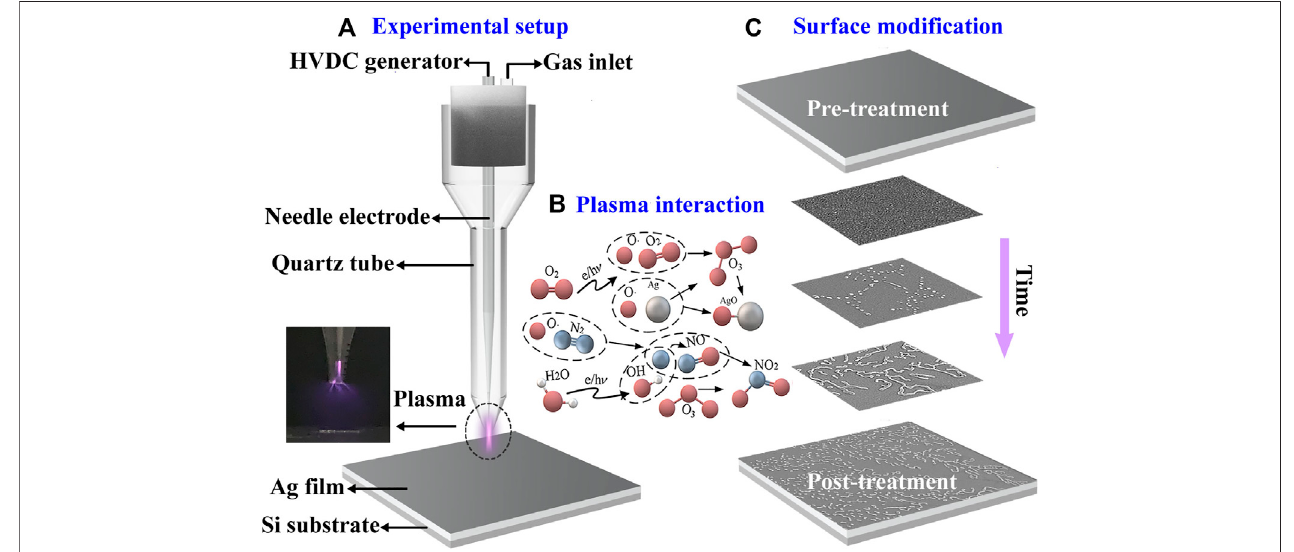
FIGURE 1 | (A) Schematic diagram of the experimental setup; (B) Related chemical process; (C) Procedure of the surface modi fi cation of the plasma-exposed silver fi lm.